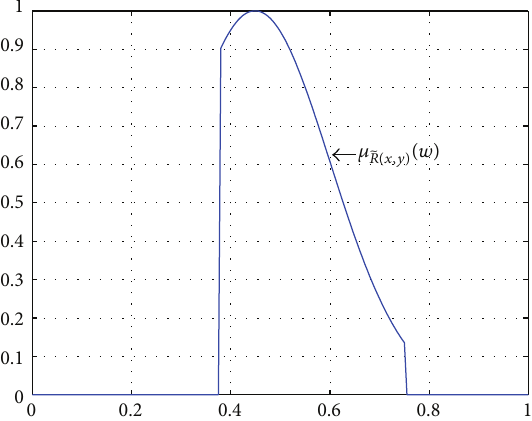
Figure 4: The function graph of 𝜇 ̃𝑅(𝑥,𝑦) (𝑤) in (80).